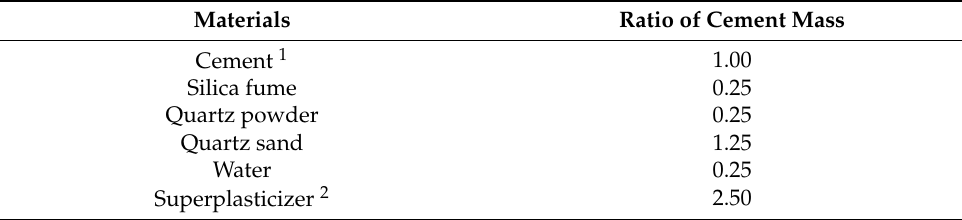
Table 2. Mixture proportions of UHPC.